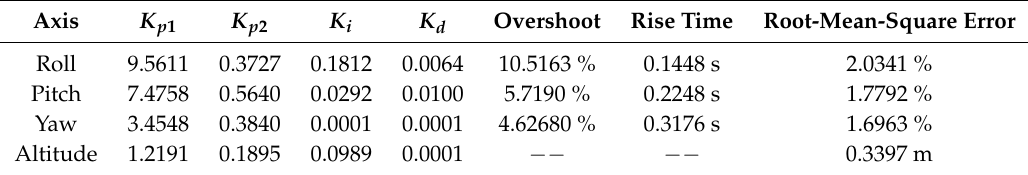
Table 4. Obtained control performance based on experimental